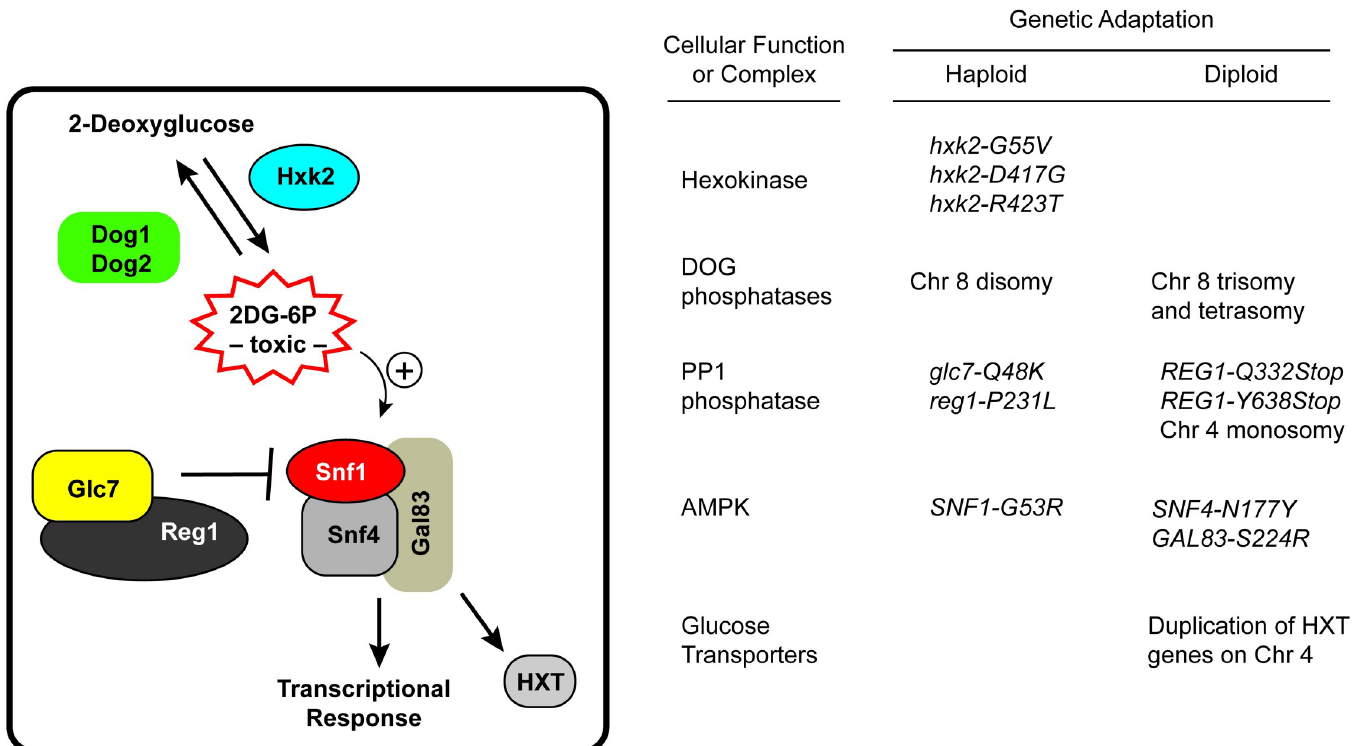
Fig 8. Genetic response to 2DG in haploid and diploid cells. A schematic representation of the yeast cell response to 2DG is shown and described in more detail in the Discussion. Genetic strategies used by haploid and diploid cells to adapt to the presence of 2DG are listed. Recessive alleles are shown in lower case and dominant alleles are shown in upper